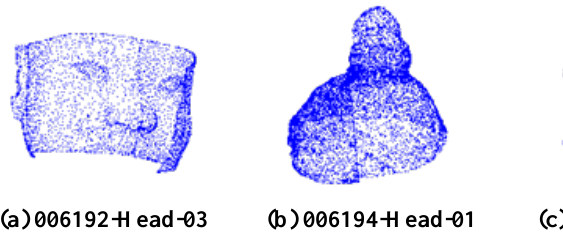
Figure 12. Some fragments of class Body. Figure 13. Some fragments of class Head.